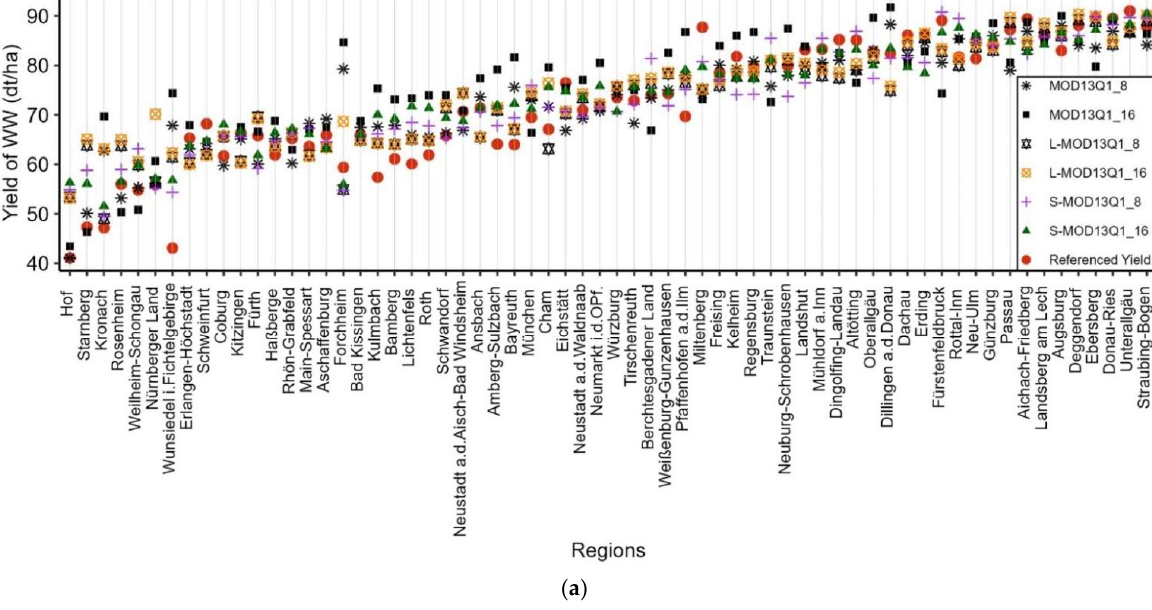
( b ) Figure 11. The dot plots show the region-wise distribution of referenced yields and modelled yields obtained from multi-source data (MOD13Q1 (8 and 16 days), L-MOD13Q1 (8 and 16 days), and S- MOD13Q1 (8 and 16 days)) for WW using ( a ) LUE and ( b ) WOFOST in 2019. The regional referenced yields are displayed in red dots.